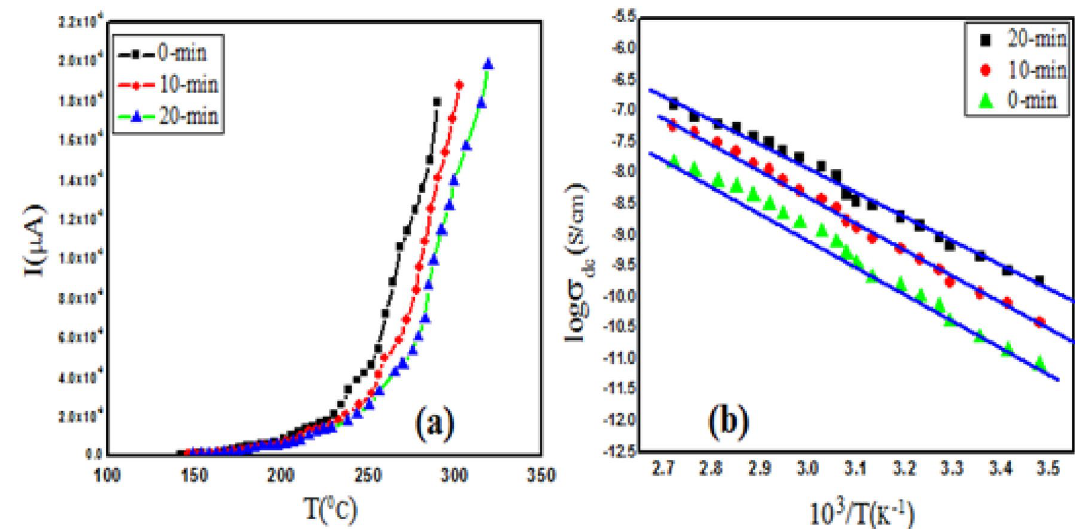
Figure 8. ( a ) Temperature dependence of dark current of as-grown and irradiated ZnO-CdO coated films. ( b ) DC conductivity beahaviour of ZnO-CdO coated films at (0-min, 10-min and 20-min) respectively.